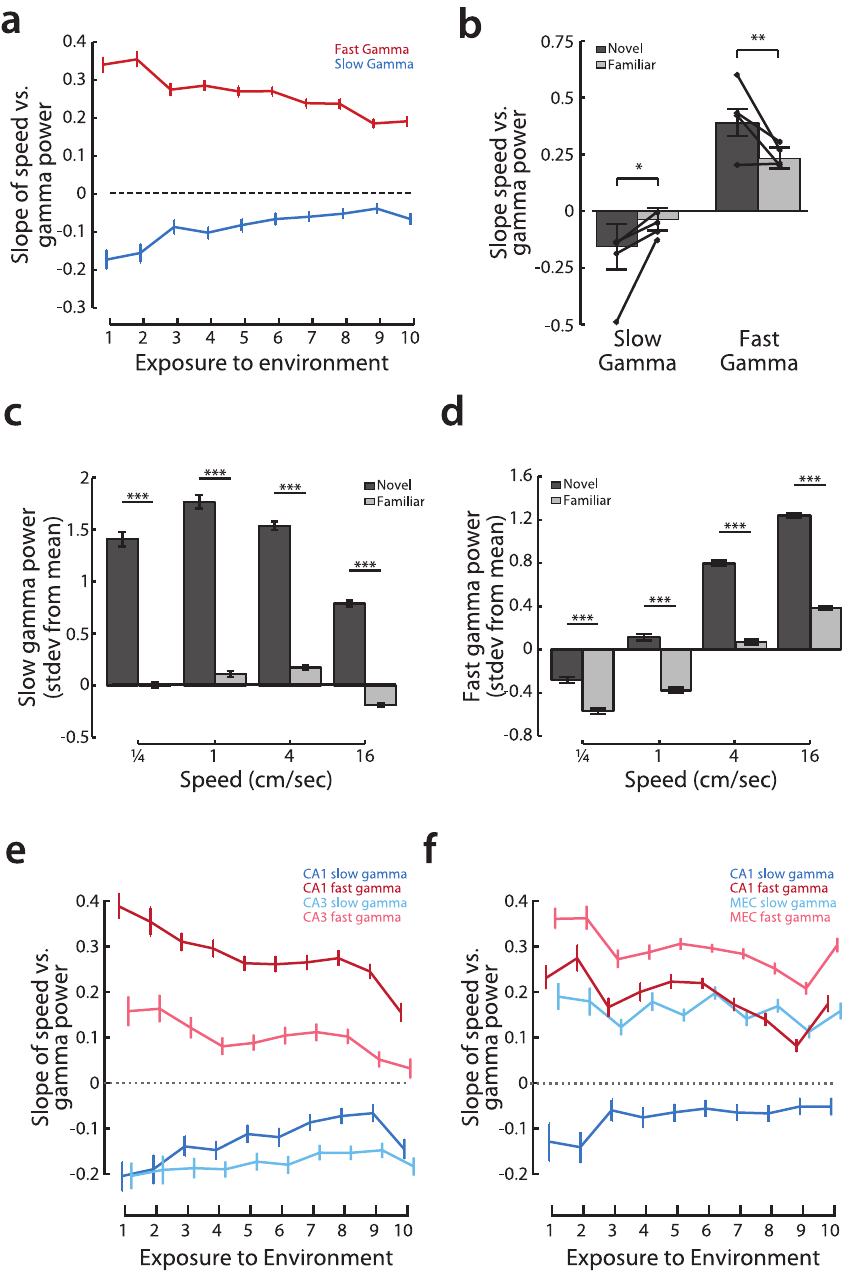
Figure 5. Novelty additionally modulates slow and fast gamma oscillations in CA1. a, Slope of the linear regression of slow and fast gamma power vs. speed plotted across exposures to the environment. Points show slope with 95% confidence bounds by bootstrap. b, The depth of gamma modulation by speed (more negative slope for slow gamma and more positive slope for fast gamma) is larger in a novel as compared to a familiar environment. Bars show grouped data, means with 95% confidence intervals, thin lines show change in slope for individual animals (bootstrap estimate of slope, novel slope vs. familiar slope; slow gamma p , 0.01 for group, p , 0.05 for individuals; fast gamma p , 0.001 for group, p , 0.05 for 3 out of 4 individual animals, one animal n.s.). *p , 0.05; **p , 0.001 c–d, Novelty enhances the depth of modulation as well as the amplitude of gamma oscillations. On days in which a second novel environment was experienced immediately following the first, more familiar environment (n=4; see methods), the effect of novelty on slow ( c ) and fast ( d ) gamma power could be directly measured. Shown are the mean binned gamma power in the novel (dark gray) and familiar (light gray) environments. Slow and fast gamma power are significantly increased in the novel as compared to the familiar environment for all speeds (rank sum test between novel and familiar session; slow gamma, p , 10 2 5 for all speed bins; fast gamma p , 10 2 5 for all speed bins). ***p , 10 2 5 . e–f, The power of slow and fast gamma oscillations in the regions which project to area CA1, CA3 and MEC, as a function of speed and novelty. Shown are the slope of gamma power vs log(speed) across exposures with 95% confidence intervals by bootstrap as in ( a ). e, Slow gamma is strongly modulated by speed, but not by novelty, in area CA3. CA3 fast gamma is weakly modulated by speed during early exposures (CA1 and CA3 data, n=4 animals). f, Fast gamma is strongly modulated by speed and novelty in EC. Unlike area CA1, slow gamma power increases with speed in EC. (CA1 and EC data, n=3 animals).